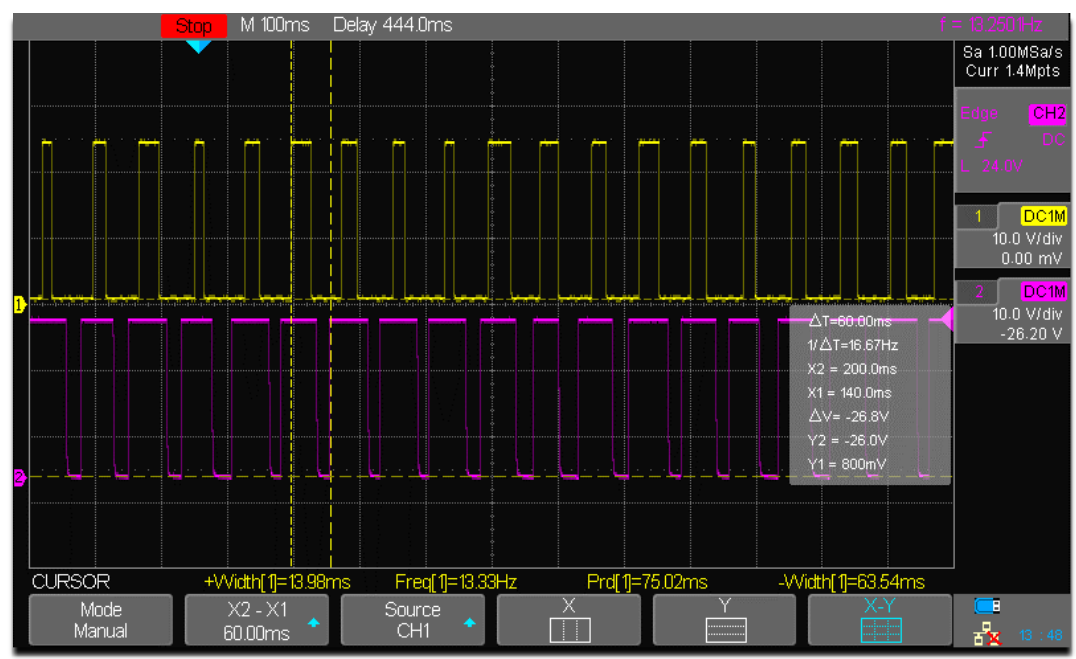
Figure 27. Phase lag between left and right wings.